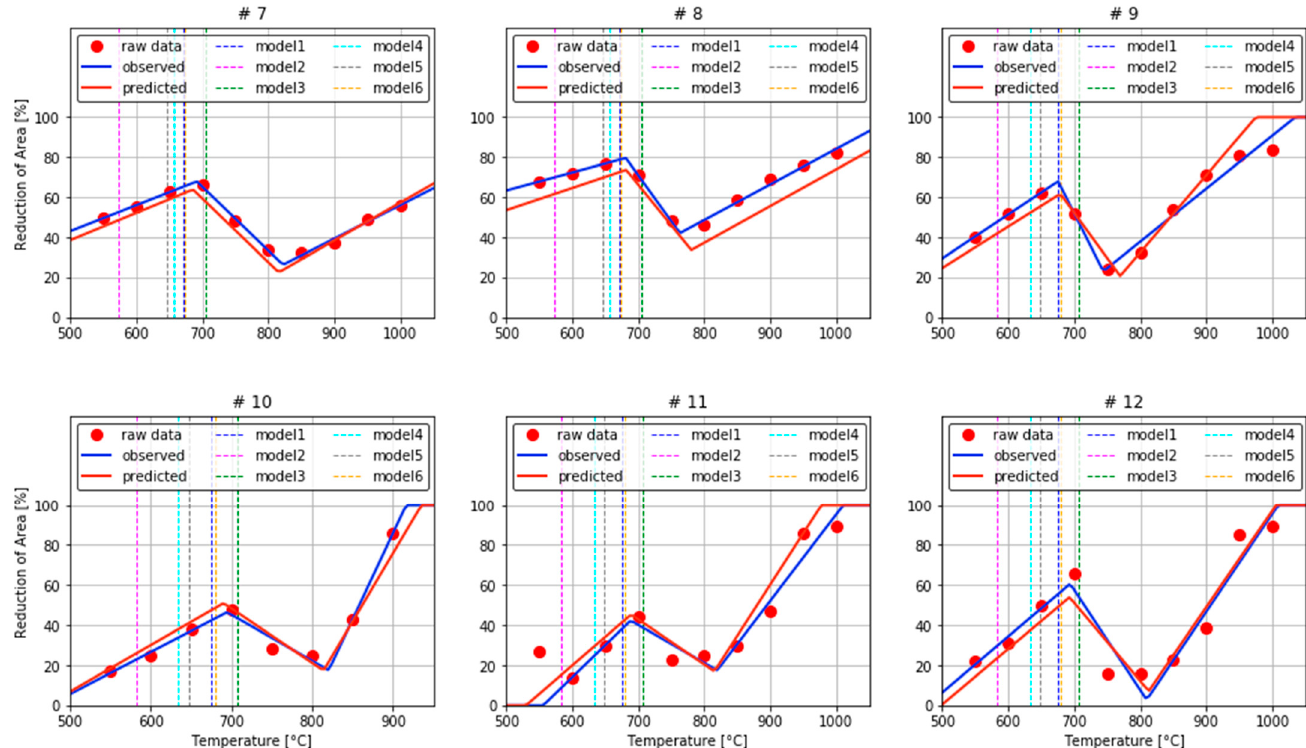
Figure 8. Comparison of the Bs temperature prediction using the existing empirical formula and the N shaped fitting model. Table 5. Error of six empirical model and RFR for